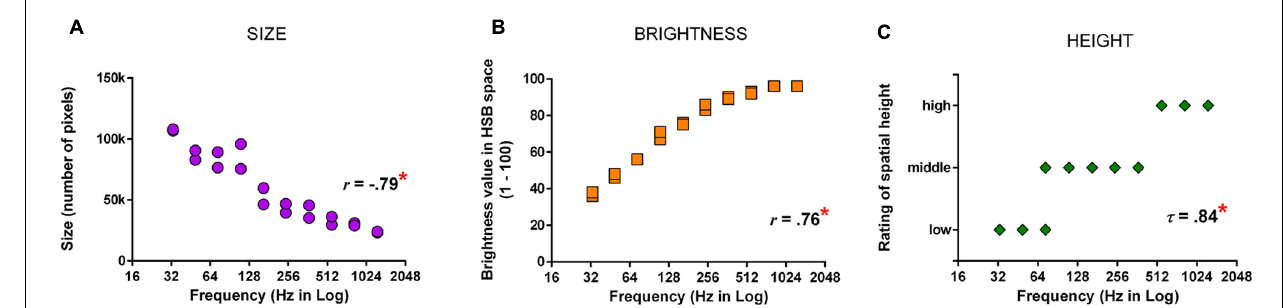
relationship between pitch and the location of synesthetic objects, indicated by categorical codings of synesthetes’ description. Asterisks indicate a statistically significant correlation ( p < 0.05). Note that there are 20 data-points (2 repetitions by 10 notes) in each figure, but some data-points are concealed due to auditory pitch (Hz) being compressed in logarithmic scale. Redrawn based on Figure 4 of Chiou etal. (2012) with permission of the